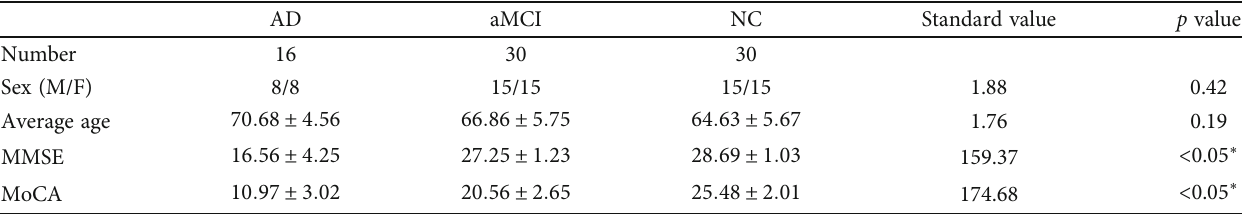
Table 1: Comparison of the basic information of the experimental subjects.